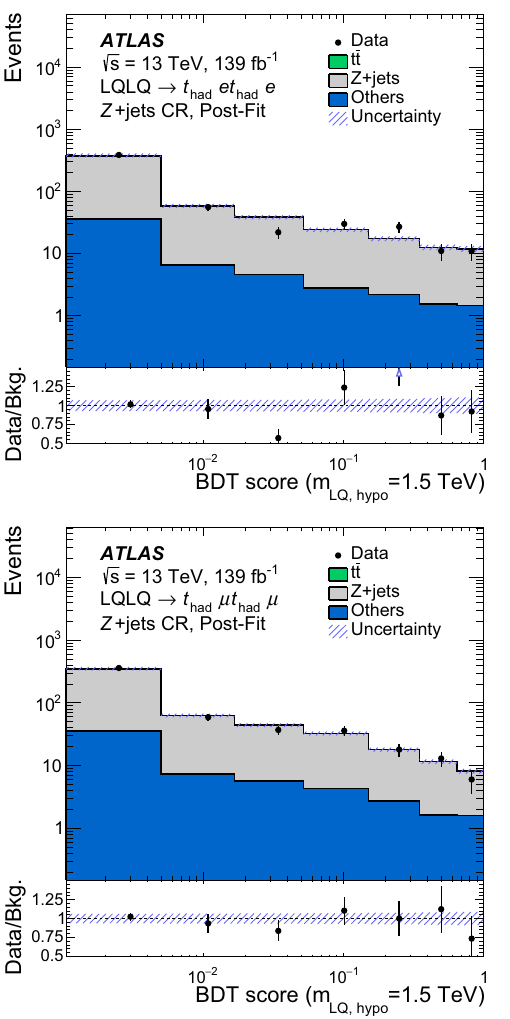
resents the total uncertainty. The blue triangles indicate points that are outside the vertical range. All BDT scores correspond to the theoretical LQ mass parameter m LQ, hypo set to 1.5 TeV. The first bin contains all underflow